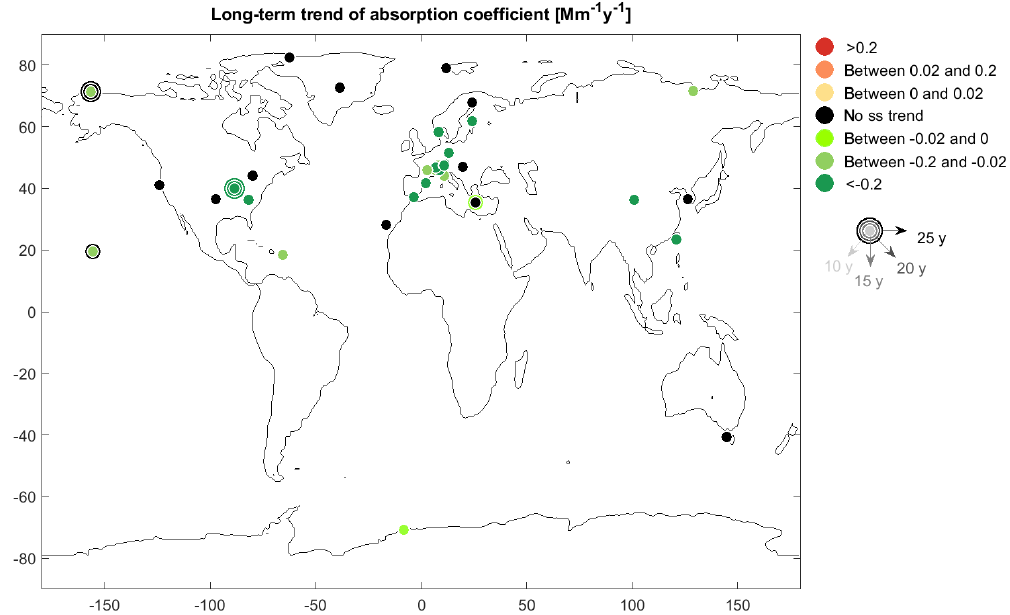
Figure 6. MK trend results for the absorption coefficient. Other details same as Fig.